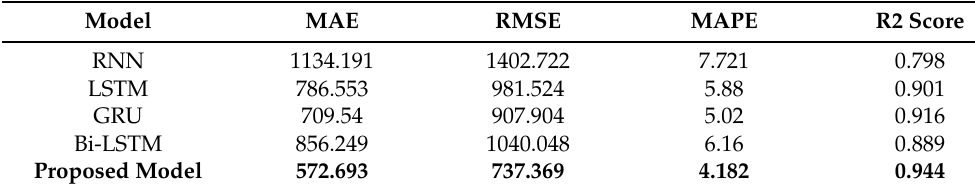
Table 2. Statistical analysis of proposed ensemble approach with conventional time-series models for hourly electric consumption Forecasting on building level.